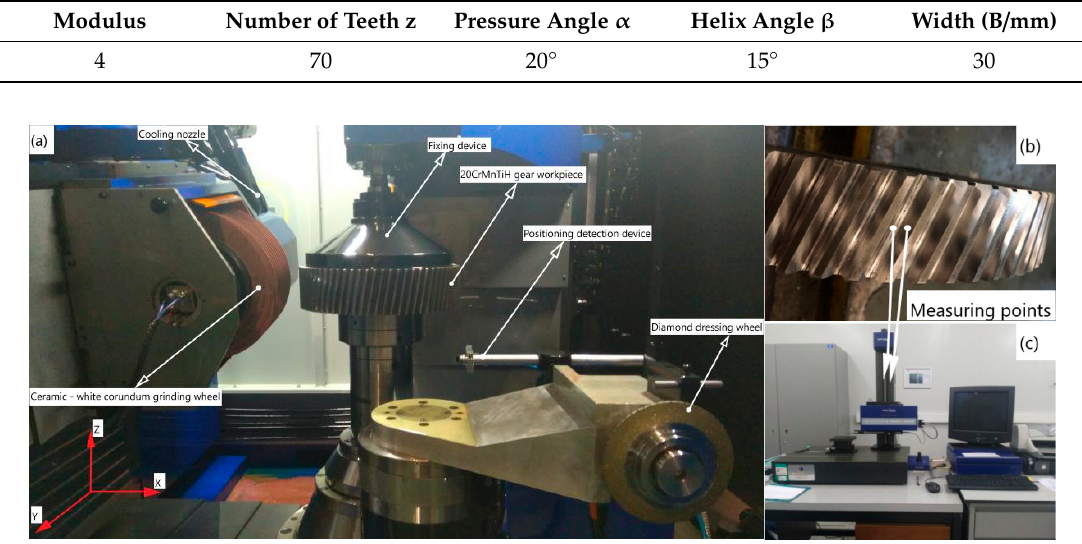
Figure 1. Flow chart of multi-objective optimization for grinding parameters. Table 5. The parameters of 20CrMnTiH gear workpieces.